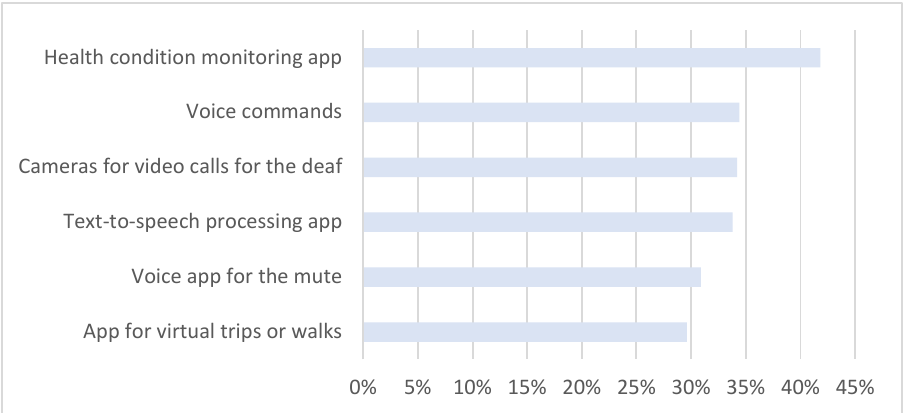
Figure 7. Conveniences for seniors and the disabled that should be available via the portal ( n = 521) (source, own research). Note: adds up to 100% as respondents were free to indicate more than one variant.